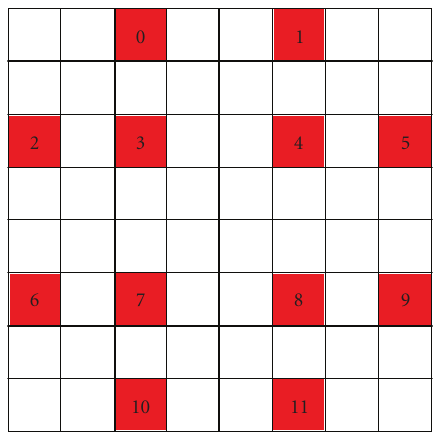
Figure 2: Initial displacement of